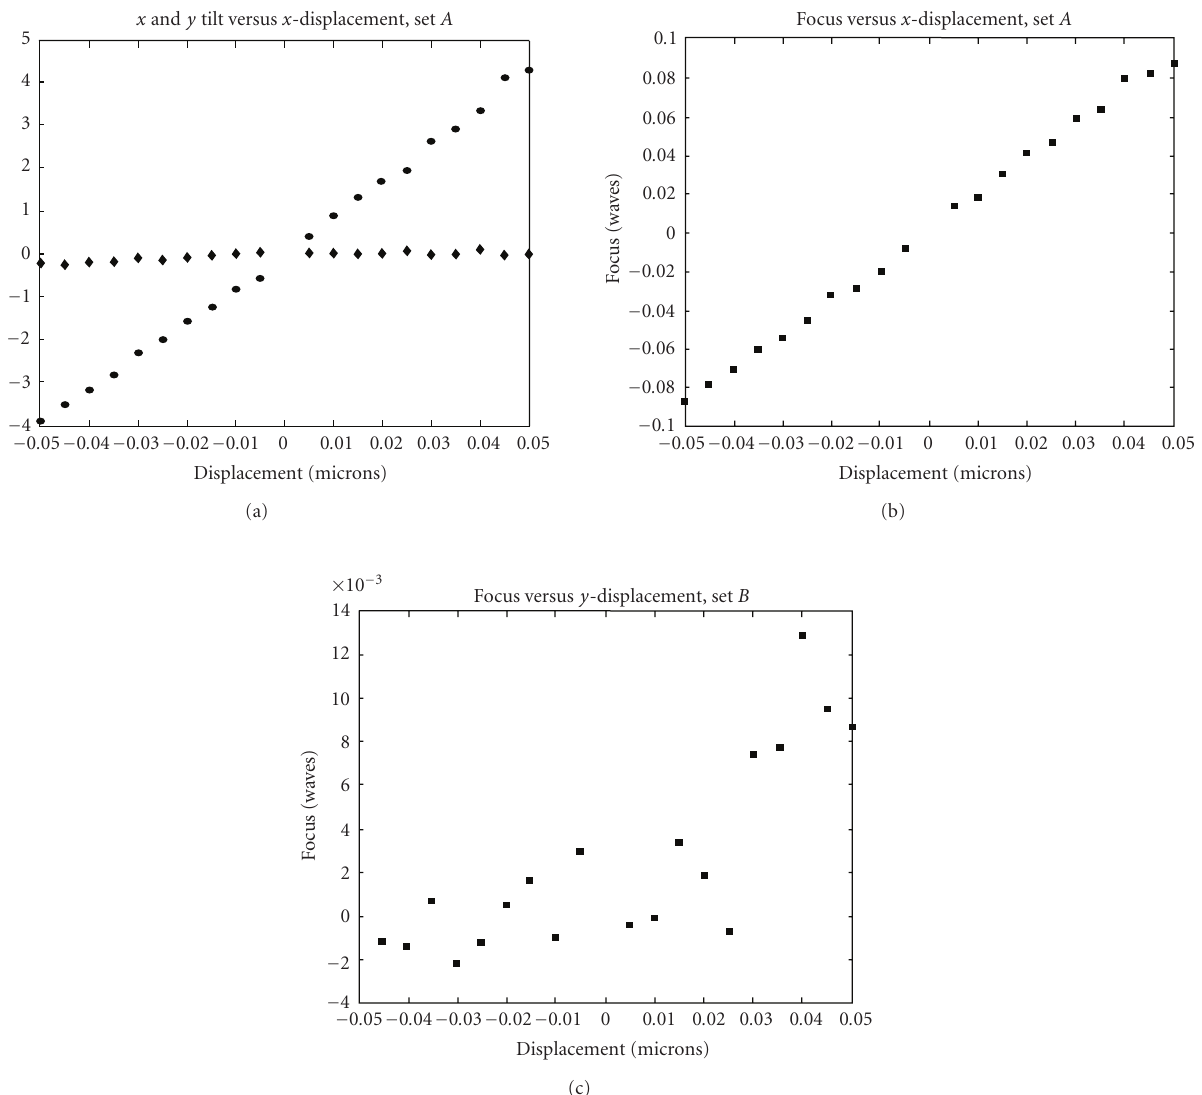
Figure 4: (a) X - and y -tilt as a function of x displacement, (b) focus as a function of x -displacement, and (c) focus as a function of x -